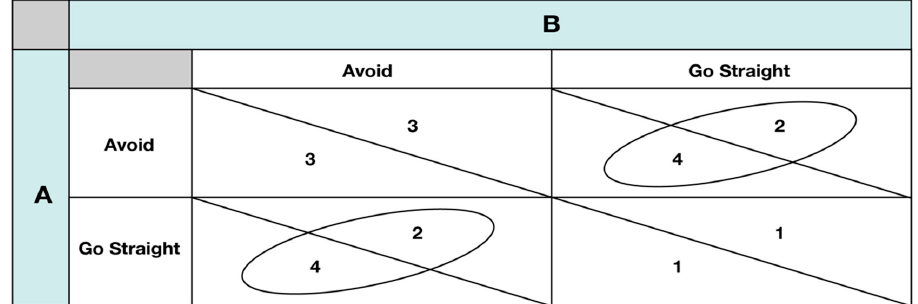
Figure 3. A description of power production situations based on a renewable/non-renewable energy source as a normal- form game.